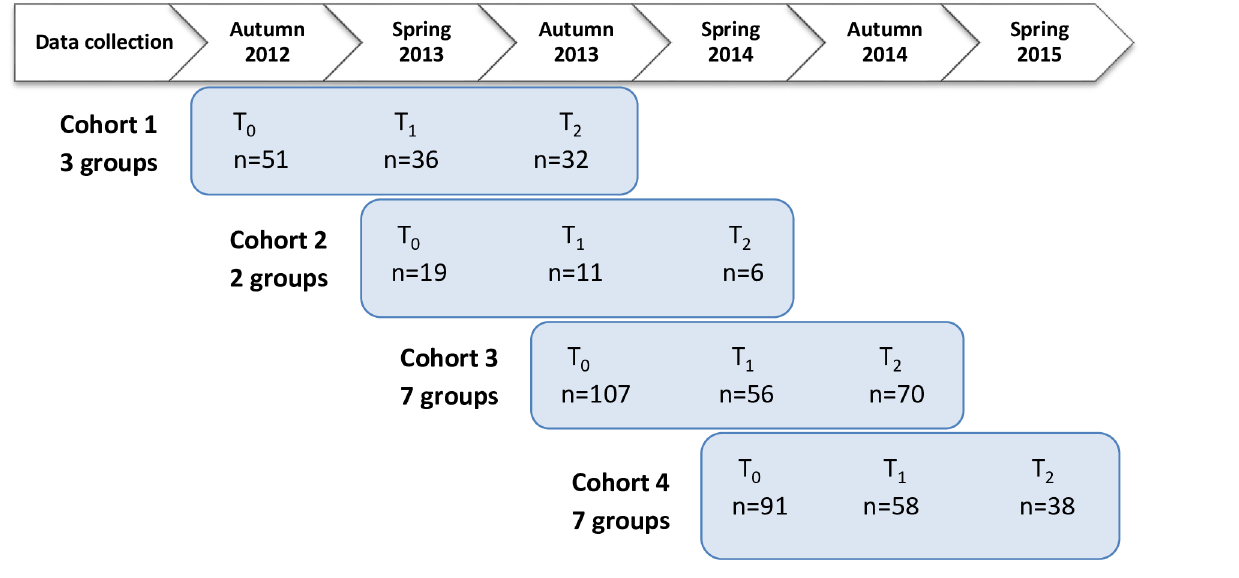
Fig 1. Data collection